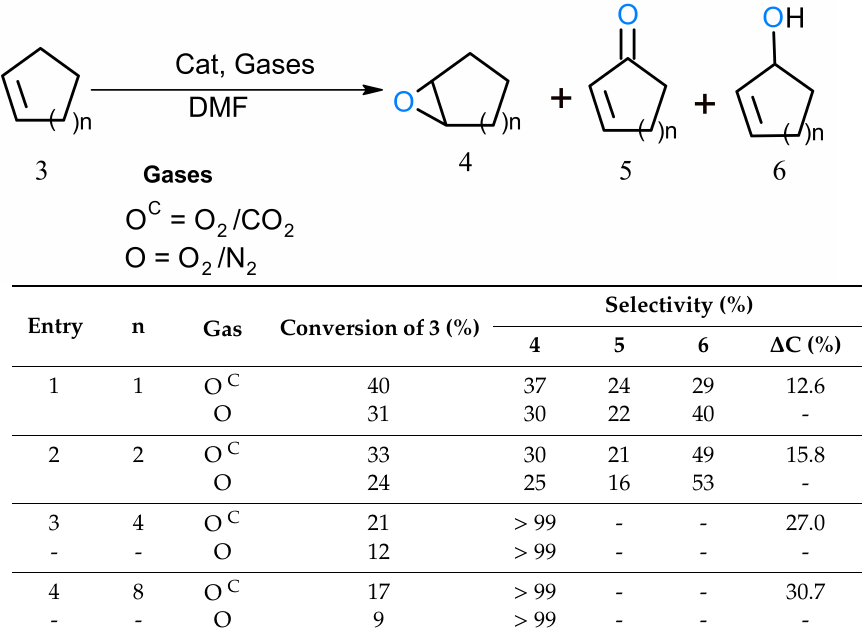
Table 2. Enhancive role of CO 2 on cyclic olefins oxidation (Reproduced from [31]; copyright (2011), Royal Society of Chemistry).